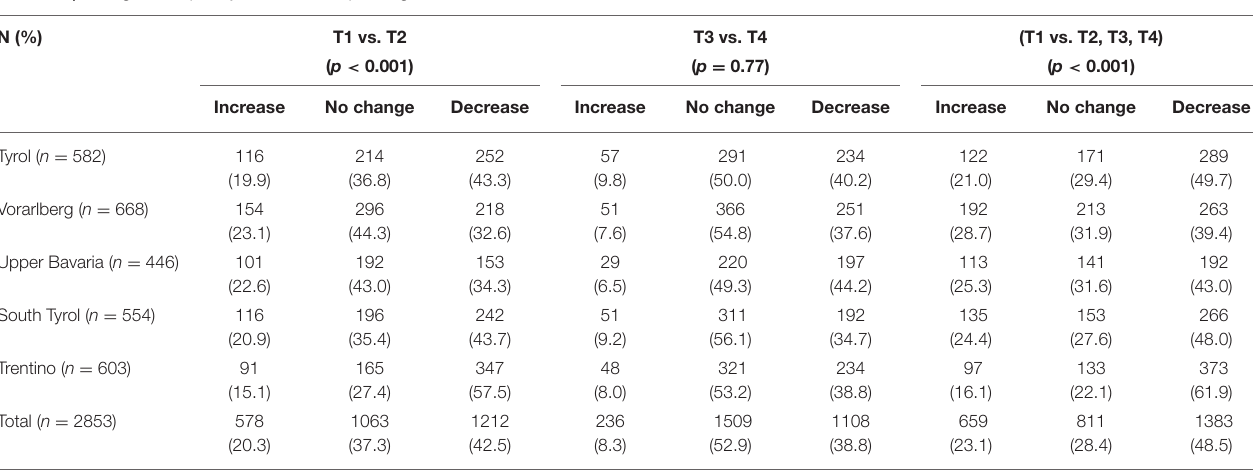
TABLE 4 | Change of frequency of PA in five Alpine